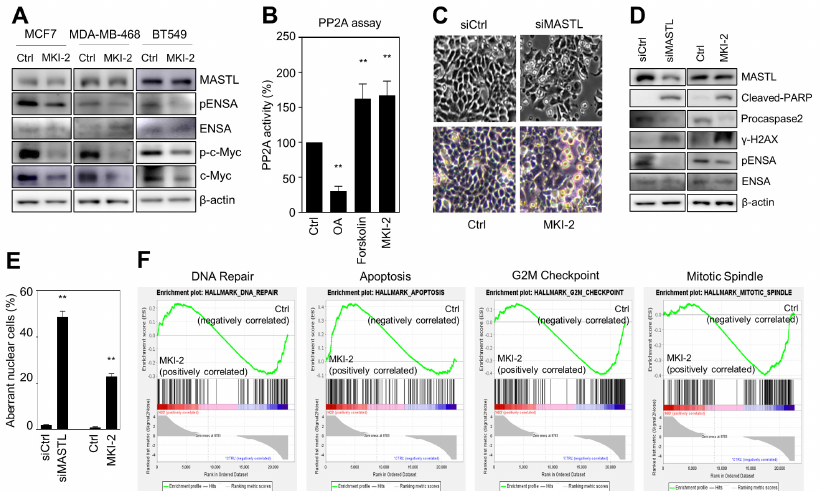
Figure 3. MKI-2 induces mitotic catastrophe of breast cancer cells via MASTL-PP2A regulation ( A ) MCF7, BT-549, and MDA-MB-468 cells were treated with DMSO (Ctrl) or 250 nM of MKI-2 for 12 h. The cell lysates were analyzed by immunoblotting with the indicated antibodies. β -actin was used as the loading control. ( B ) PP2A activity in MCF7 cells was measured after treatment of DMSO (Ctrl), 50 nM OA, 160 µ M forskolin, or 250 nM MKI-2 for 24 h. ( C – F ) MCF7 cells were transfected with control siRNA or MASTL siRNA, or treated with DMSO(Ctrl) or 250 nM MKI-2 for 24 h. ( C ) The representative cell images. Scale bars = 20 µ m. ( D ) The cell lysates were analyzed by immunoblotting with the indicated antibodies. β -actin was used as the loading control. ( E ) The aberrant nuclear cells, such as nuclei with irregular shapes or fragmented nuclei were scanned and determined using the IN Cell Analyzer HCA System. In at least 17 images, each image that contains more than 100 cells was analyzed from each group by the IN Cell analyzer. ( G ) mRNA Transcripts from MKI-2-treated cells were analyzed by GSEA software. The data represent typical results and are presented as the mean ± standard deviation of three independent experiments. ** p < 0.01.